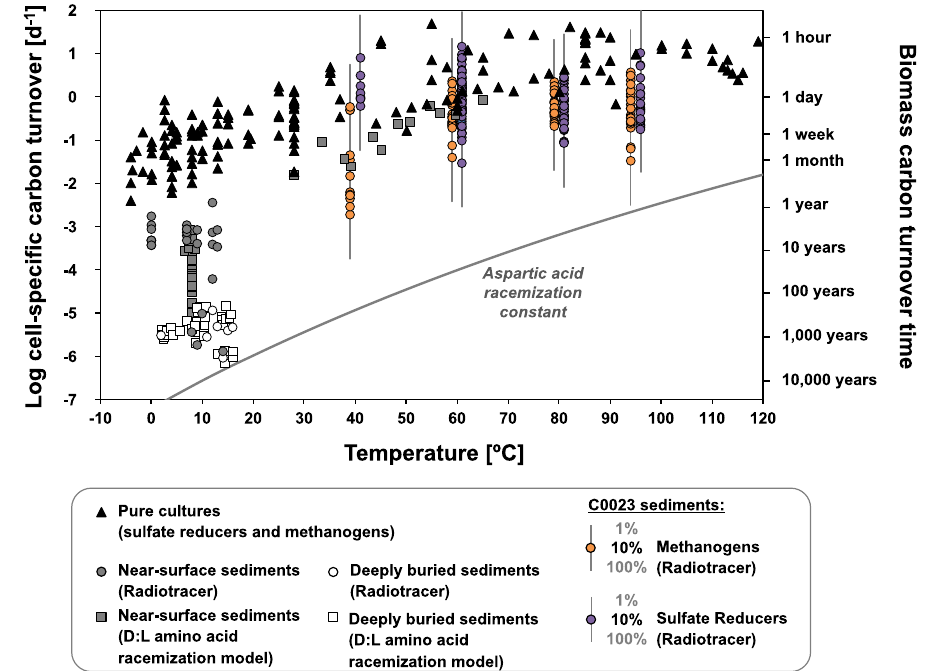
Fig. 2 Estimates of potential cell-speci fi c carbon turnover in C0023 sediment in relation to temperature, and comparison with microbial turnover in other marine sediment 33,34,67 – 71,73 – 75 and in pure cultures 11,38 – 42,70 . Data were compiled and recalculated as mol C assimilated per mol C cell per day (see Supplementary Material). For the pure cultures, this turnover corresponds to generation times. Bars indicate the range of potential C0023 biomass turnover estimates for a prokaryotic population with 1 – 100% sulfate reducers and/or methanogens. As acetate and methane additions resulted in a stimulation of sulfate reduction in <350 mbsf sediments, estimates of potential biomass turnover time in these depths are solely based on activity measurements from incubations with trace H 2 . D:L = ratio between the D and L isomeric forms of aspartic acid. Symbols referring to data sets from different marine sediments, cultures, and incubations are de fi ned in the legend. Source data are provided as a Source Data fi